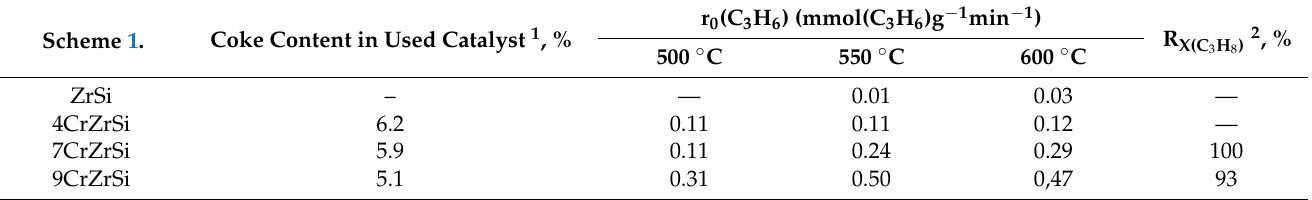
Table 3. The initial rates of propylene formation (r 0 (C3H6)) for ZrSi and CrZrSi catalysts and degree of propane conversion recovery (R X ( C 3 H 6 )